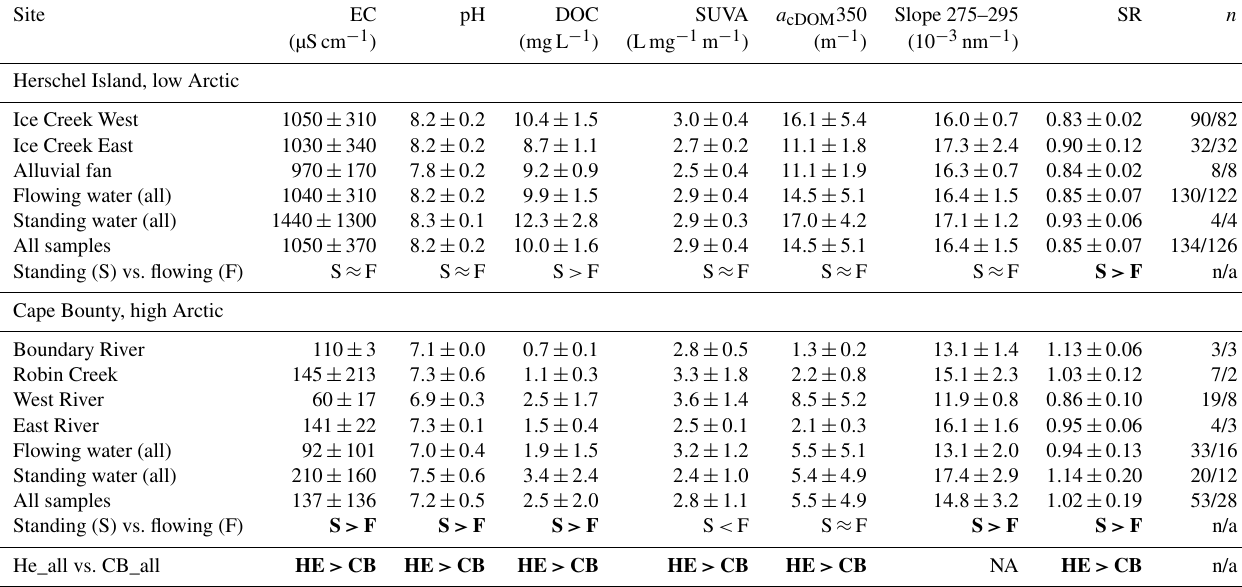
Table 2. Descriptive statistics (mean ± standard deviation) of dissolved organic carbon, DOC (mgL − 1 ), specific ultraviolet absorbance, SUVA (Lmg − 1 m − 1 ), coloured dissolved organic matter (cDOM) absorption at 350nm, a cDOM 350 (m − 1 ), cDOM slope S275–295 (10 − 3 nm − 1 ), slope ratio SR, electrical conductivity EC (µScm − 1 ), pH, and the number ( n ) of all samples/samples with cDOM